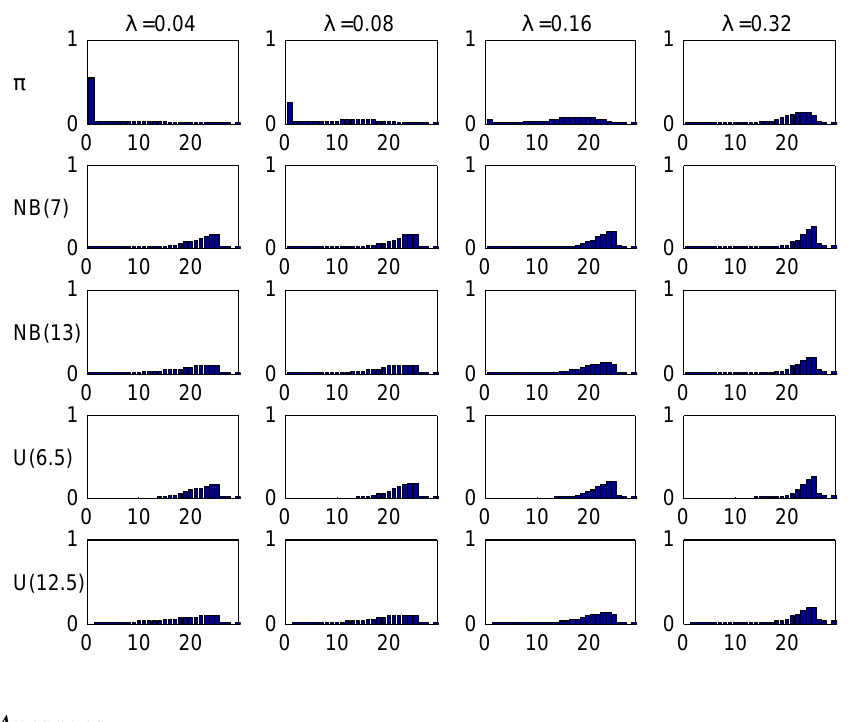
Figure 11. Stationary and age-corrected distributions,